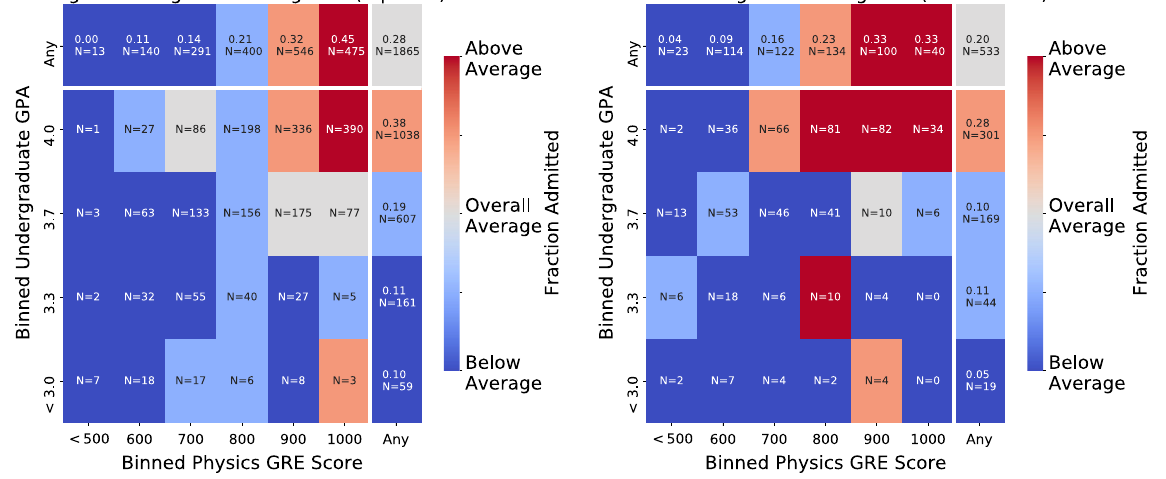
FIG. 5. Fraction of applicants admitted by undergraduate GPA and physics GRE score and split by large or small undergraduate